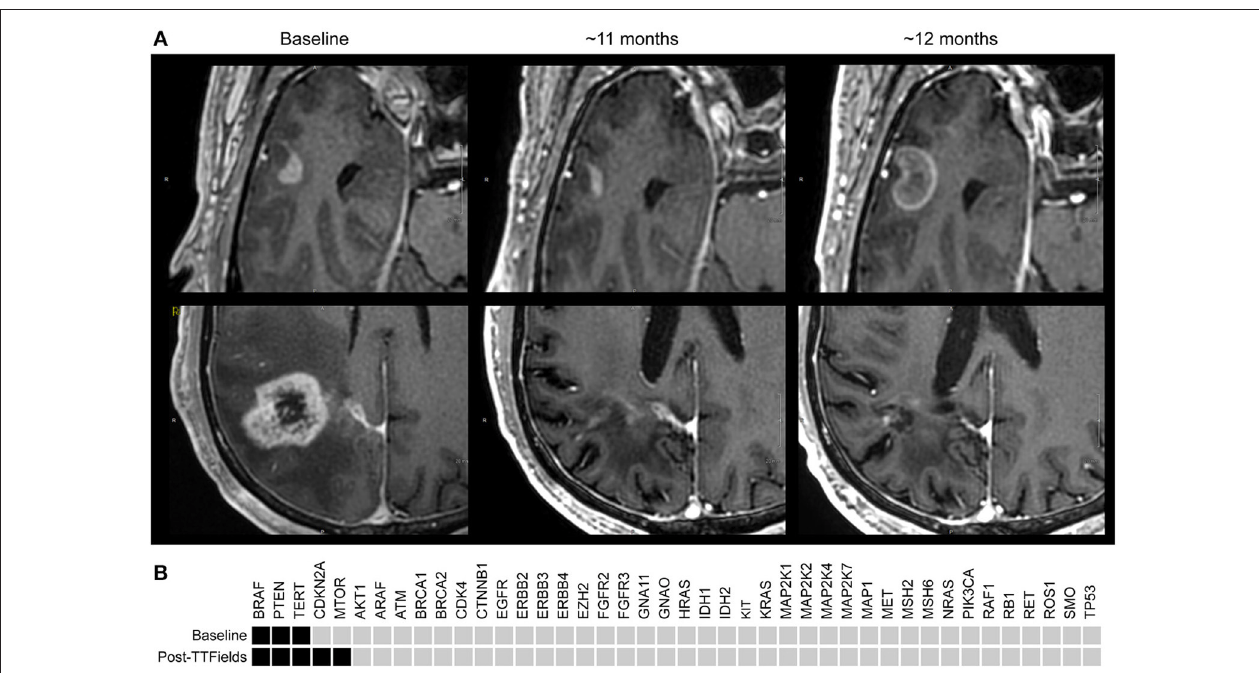
FIGURE 1 | (A) T1 + contrast MRI images: Upper panels are right temporal lobe; lower panels are corresponding right parietal images. Baseline (Aug. 2016) demonstrates the first appearance a temporal lobe lesion ∼ 2 months post radiation/temozolomide; the lower panel demonstrates the primary GB. Middle section ∼ 11 months later (June 2017) demonstrates slightly less enhancement of the temporal lobe lesion, and a dramatic reduction in enhancement and size of the parietal lobe lesion with decreased edema and treatment related cerebral atrophy. At ∼ 12 months (Aug. 2017) the temporal lobe lesion has increased to 18 × 13mm; the parietal lobe remains stable and in remission. (B) StrataNGS cancer hotspot sequencing was performed on the resection of the primary parietal lobe lesion, which possessed mutations in BRAF (V600E), PTEN (319fs), and the TERT promoter (C228T). Following progression on TTFields, the separate anterior temporal lesion was resected and demonstrated BRAF , PTEN, and TERT alterations, and the acquisition of a deep deletion of CDK2NA and an activating mutation in mTOR (V2006I). No other pathologic alterations were identified in the remaining 47 genes of the 88 genes assessed.